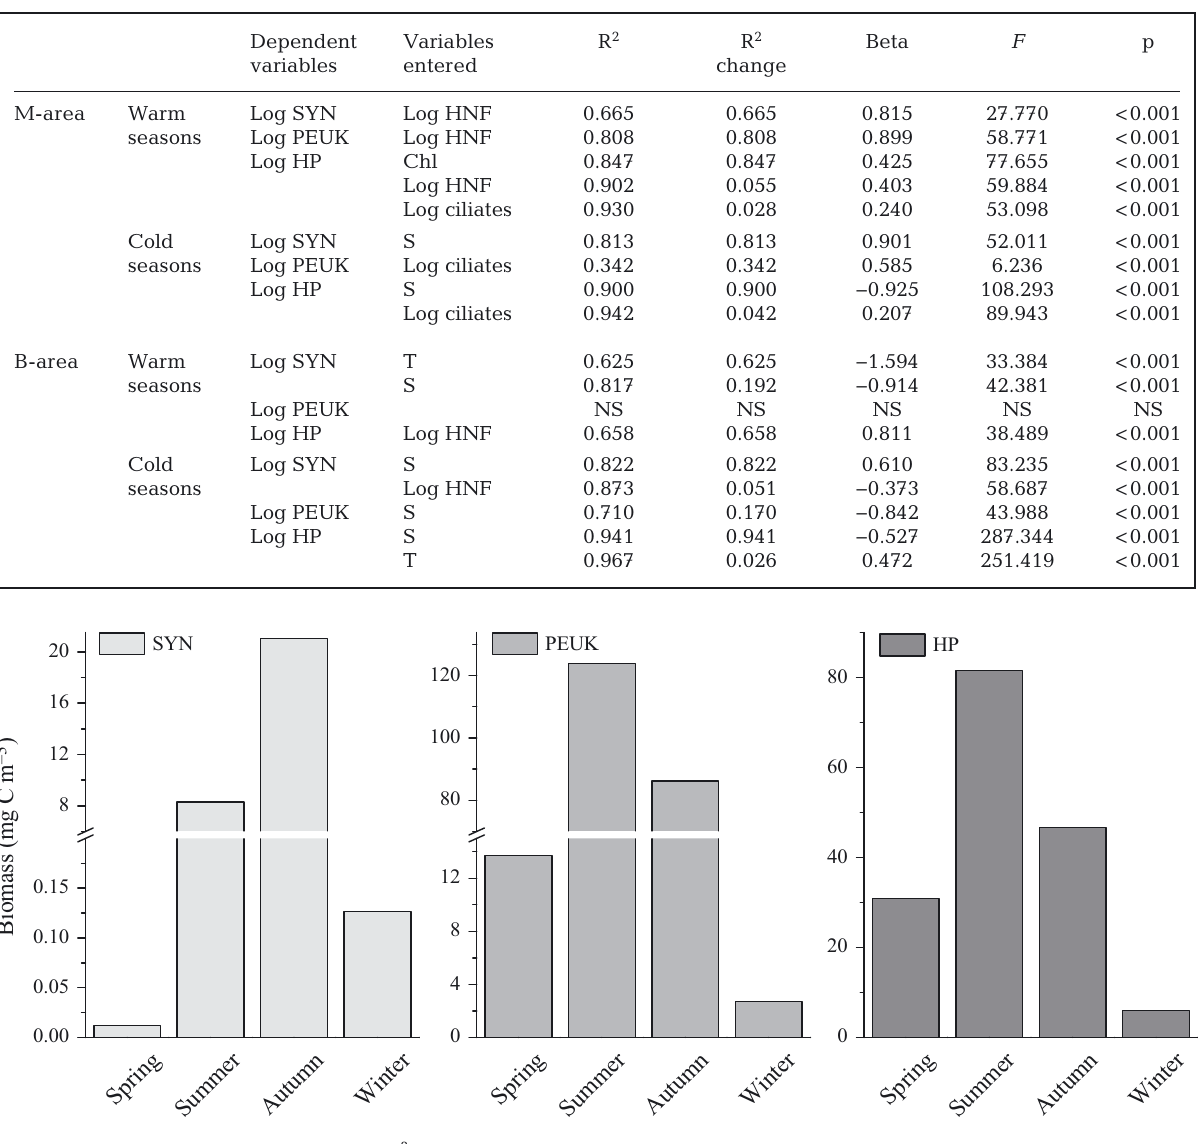
Fig. 4. Depth-averaged biomass (mg C m −3 ) of picoplankton in Sanggou Bay over 4 successive seasons. SYN: Synechococcus ; PEUK: picoeukaryotes; HP: heterotrophic prokaryotes. Note different y -axis